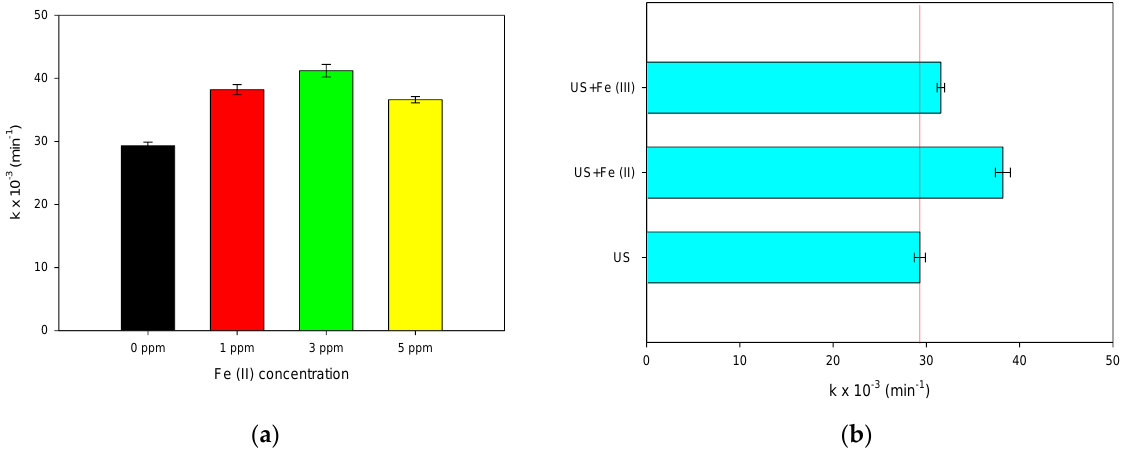
Figure 3. Homogeneous sono-Fenton for degrading MO as the probe compound. ( a ) Effect of iron (II) ions concentration; ( b ) Effect of the iron species (II or III, at 1 ppm (mg L −1 )). Experimental conditions : f: 375 kHz, P: 34.4 W, [MO] initial : 30.6 µmol L −1 , pH initial : 5.6, and V: 250 mL.